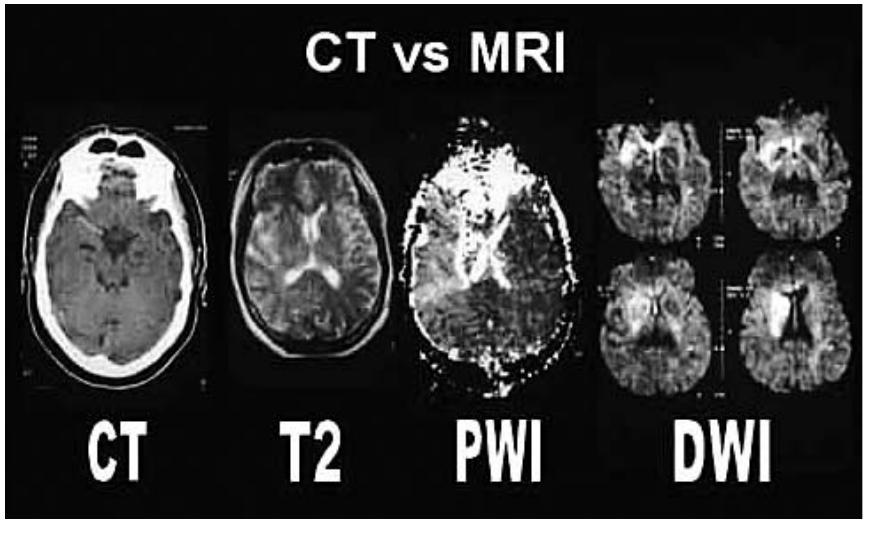
Figure 1 Patient with signs of acute cerebral ischaemia. The CT shows a dense mid- dle cerebral artery. MR imaging was per- formed whch shows no signs of major in- farction on T2- weighted MRI. The perfusion image shows a large area of hypoperfusion in the middle cerebral ar- tery territory. The dif- fusion images show an area of smaller diffusion